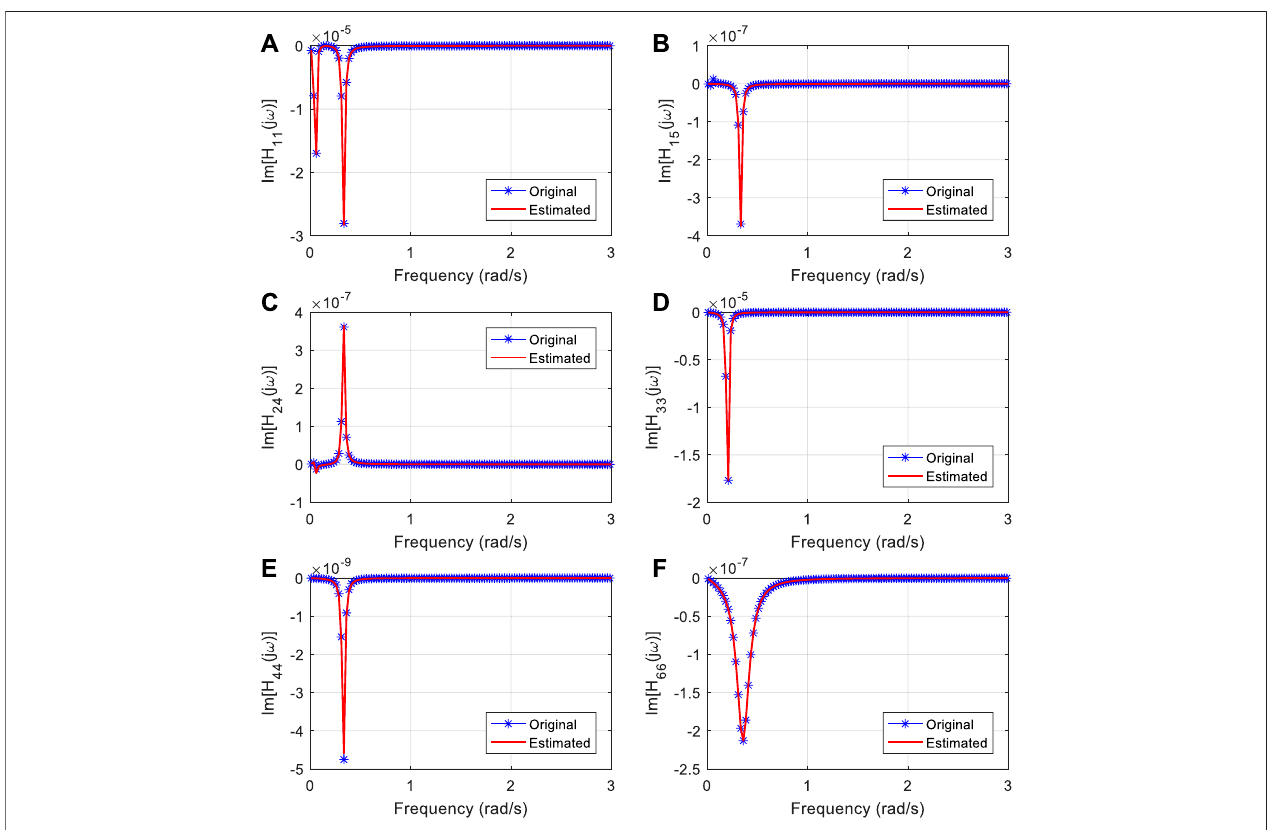
FIGURE6| Imaginarypartcomparisonoftheoriginalandestimatedtransferfunction.Dynamicresponsecalculationofspar-type fl oatingoffshorewindturbine. (A) H11(jw); (B) H15 (jw); (C) H24(jw); (D) H33(jw); (E) H44(jw) and (F) H66(jw).